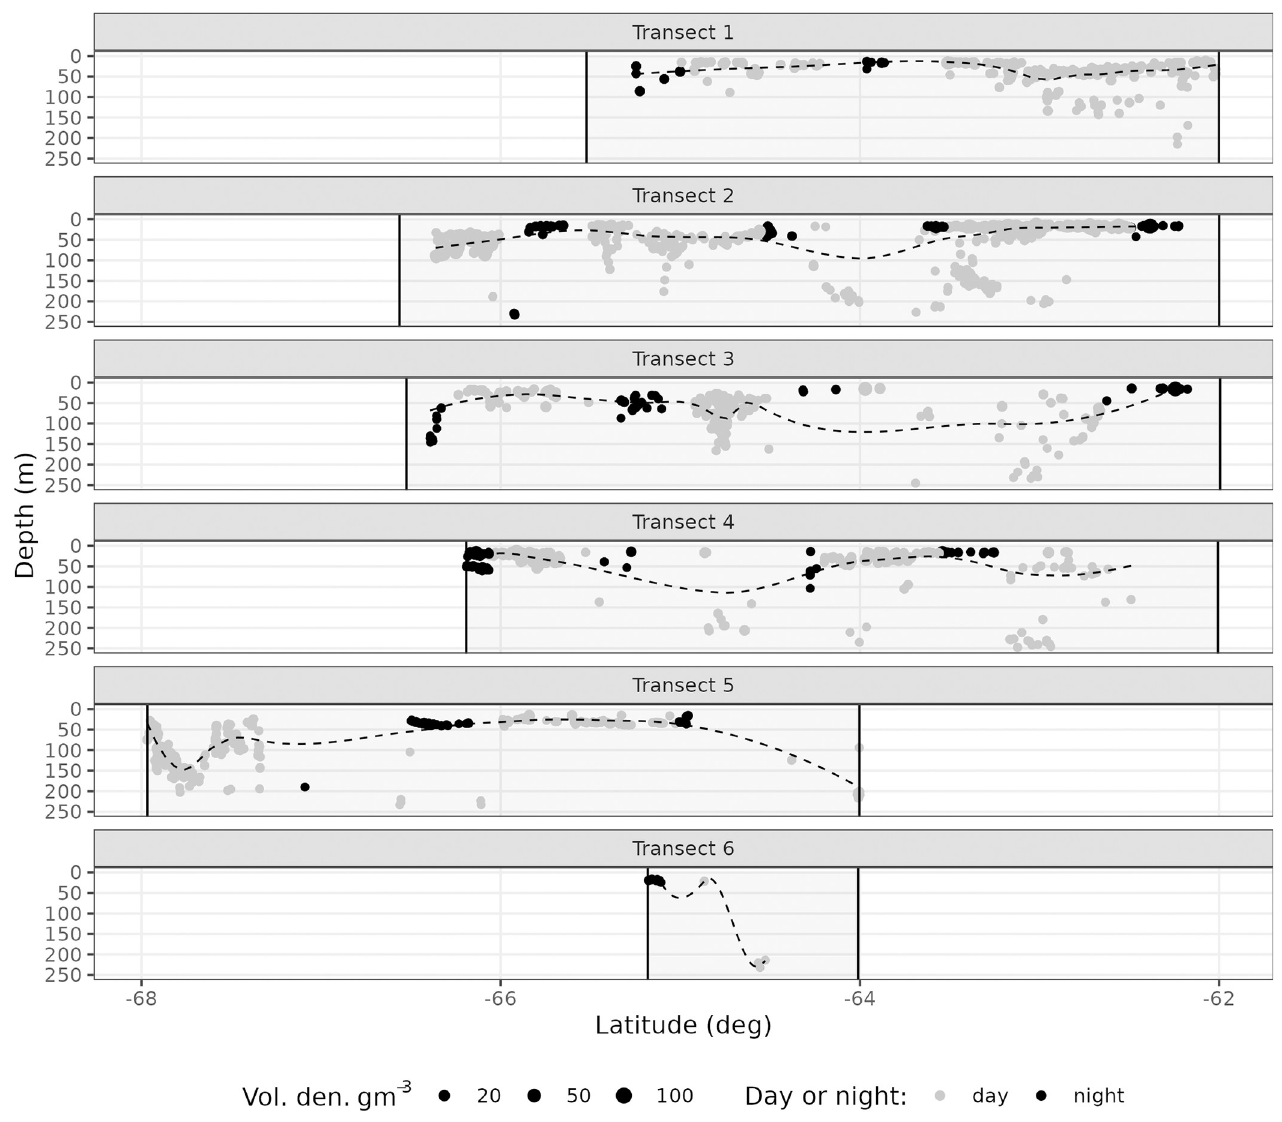
Fig 7. Diel patterns of krill swarm depth and internal density for each transect. Each of the six transects is shown on a separate panel labelled 1 to 6. NB the different start and end latitudes (x-axis) for each transect are denoted as grey rectangles. Day and night are defined as civil day-night and swarms coloured light grey for day and dark grey for night. The area of each swarm circle is proportional to internal swarm volumetric density (gm -3 ) and the black dashed line is a LOESS smooth (span = 0.4) through the centre of mass, i.e. the mean swarm depth weighted by mean swarm internal